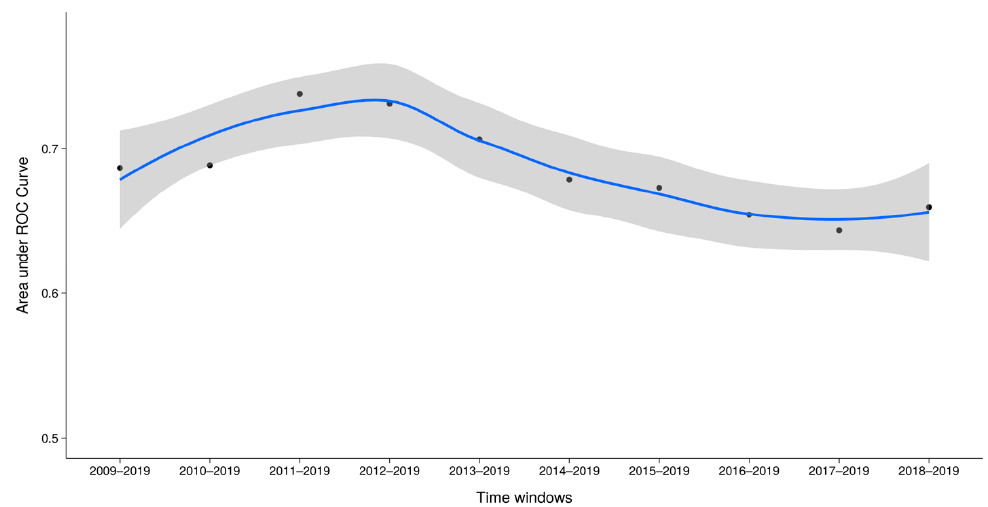
Figure 4. AUC_ROC for all models. Table 3. Higher coe ffi cients for the logistic regression fi xed-e ff ects model to the period of 2012–2019 and the number of times these variables were in the same top 7 ranking in other periods.